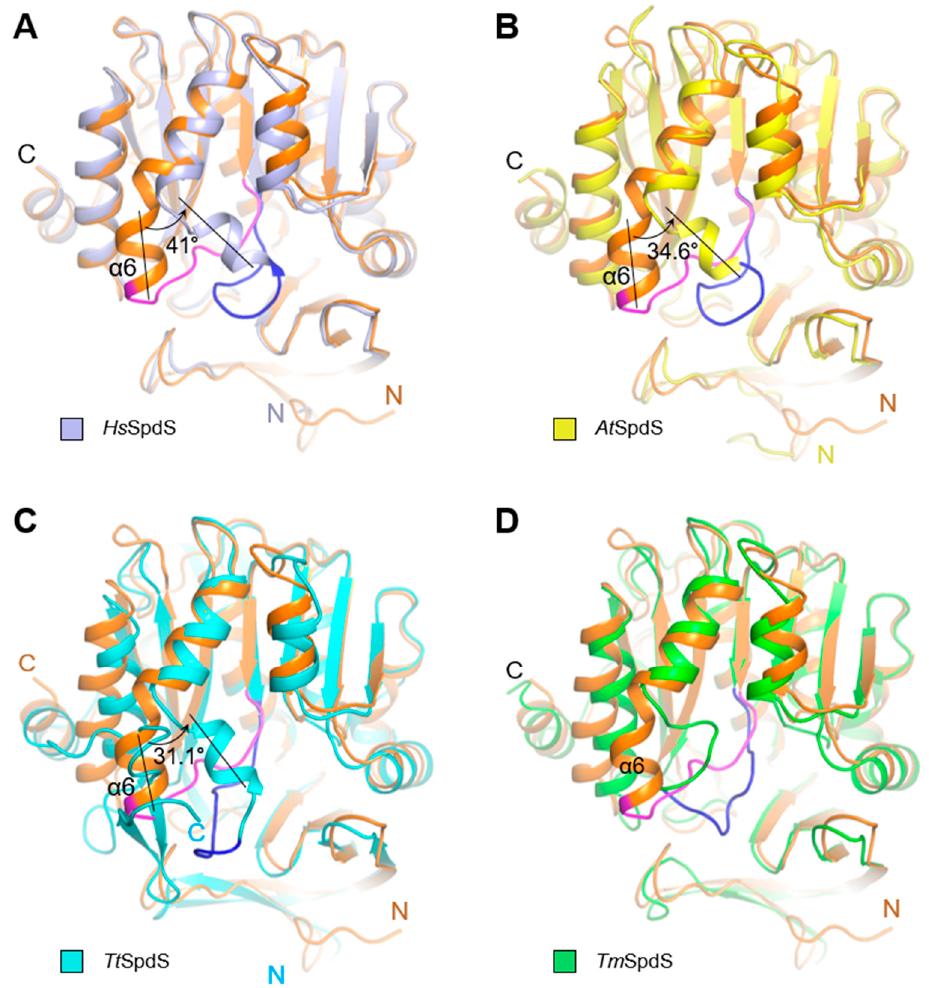
Figure 2. Comparisons of the gate-keeping loop between the apo structure of spermidine synthase from Kluyveromyces lactis ( Kl SpdS) and four other species. Each figure represents the superposition of the monomers to compare the gate-keeping loop. In ( A – D ), the monomer of the apo- Kl SpdS is colored orange. ( A ) Superposition of apo- Kl SpdS with that of SpdS from Homo sapiens ( Hs SpdS; PDB code 2O0L). The Hs SpdS monomer is shown in light blue. ( B ) Superposition of the apo- Kl SpdS with that of SpdS from Arabidopsis thaliana ( At SpdS; PDB code 6O63). The At SpdS monomer is shown in yellow. ( C ) Superposition of apo- Kl SpdS with that of SpdS from Thermus thermophilus ( Tt SpdS; PDB code 1UIR). The Tt SpdS monomer is shown in cyan. ( D ) Superposition of apo- Kl SpdS with that of SpdS from Thermotoga maritima ( Tm SpdS; PDB code 1INL). The Tm SpdS monomer is shown in lime green. The purple color indicates the gate-keeping loop of Kl SpdS, wherease, the gate-keeping loops from compared structures were colored in blue. Table 1. Structural similarity comparison for homologous structures of spermidine synthase among fi ve species using Dali a .